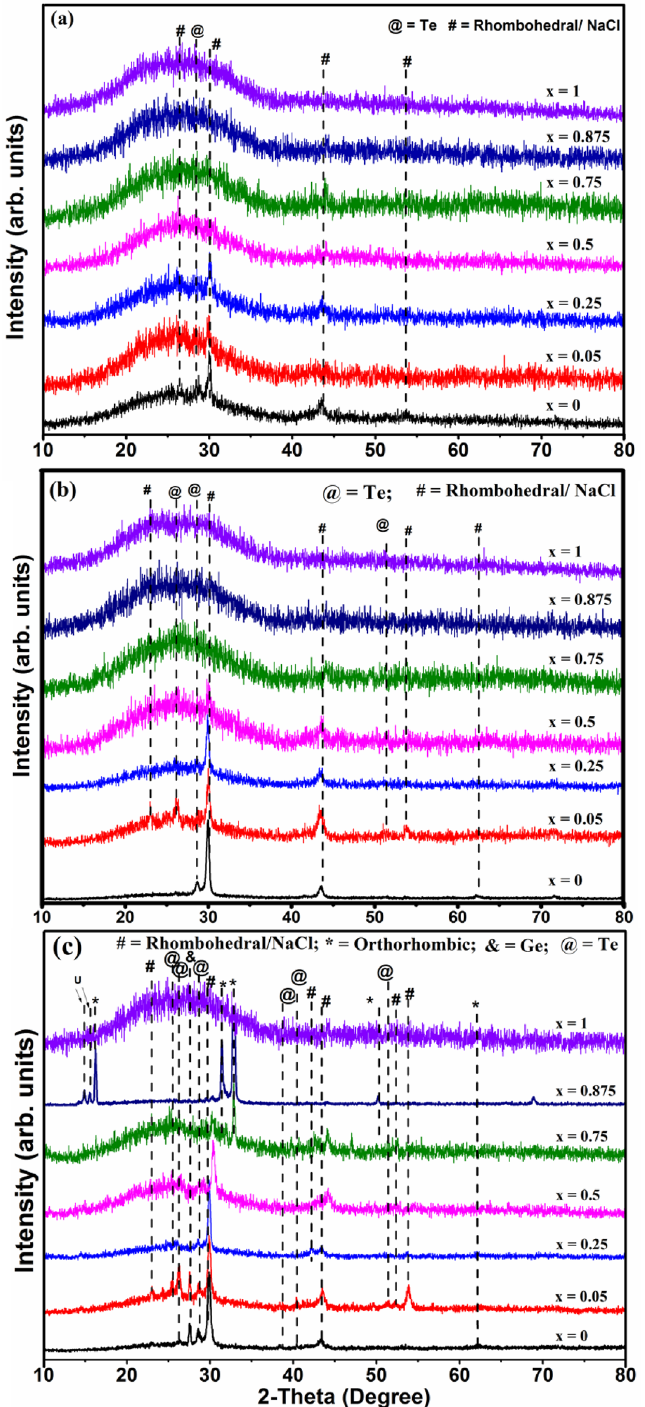
Figure 4. XRD of the samples annealed at ( a ) 150, ( b ) 200 and ( c ) 300 °C showing the evolution of the crystalline